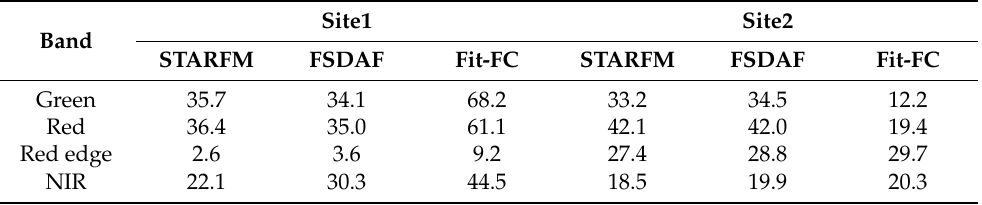
Table 4. Relative improvement in RMSE of HIFOW over three STIF models at the two study sites (unit: